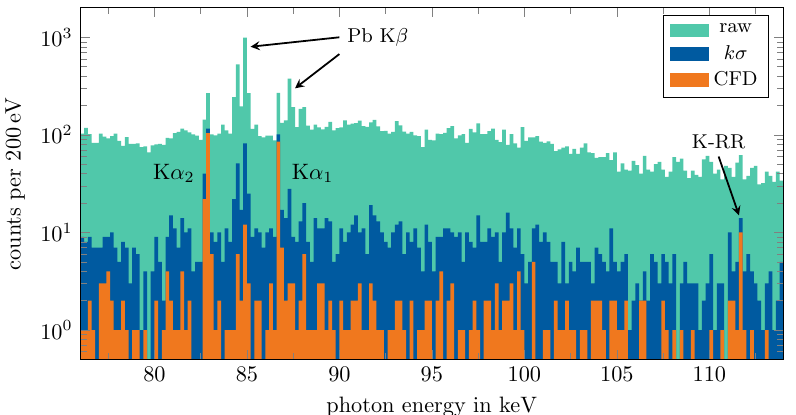
Figure 3. Demonstration of the background reduction achieved by means of a coincidence measure- ment. The spectrum without application of a coincidence condition is marked as ‘raw’ and compared with the spectra with an appropriate coincidence condition for the k σ trigger and the CFD trigger, re- spectively. The distinct spectral features are labelled. Those stemming from U 90 + appear prominently in the coincident